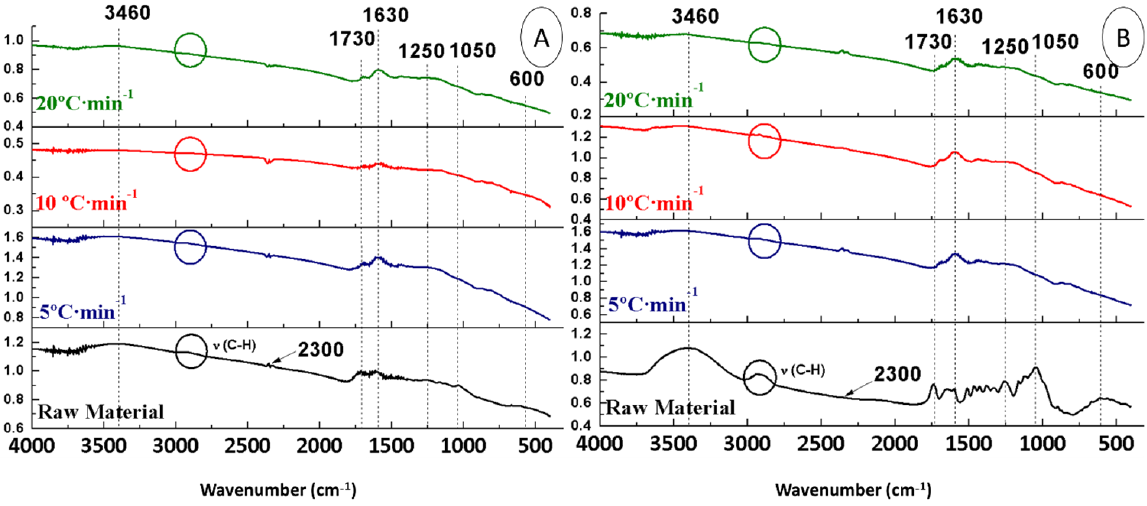
Figure 4. FTIR spectra of biochars from OS + H 2 SO 4 ( A ) and OS ( B ) at different heating ramps.